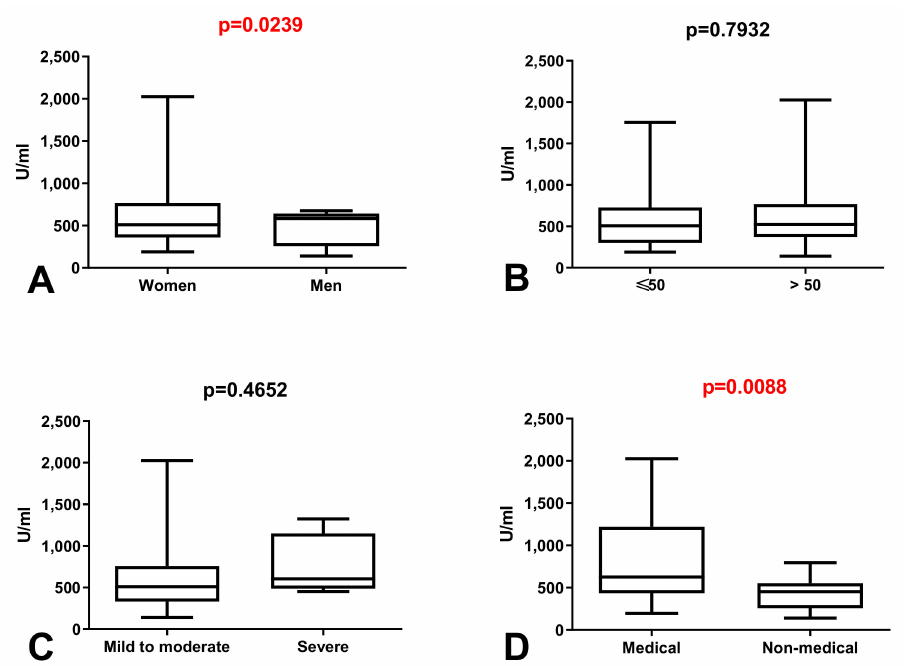
Figure 1. ( A ) Comparison of total anti-SARS-CoV-2 antibodies level between group of women and men without history of COVID-19. The data are presented as median (minimum–maximum). ( B ) Comparison of total anti-SARS-CoV-2 antibodies level between groups of patients before and after the age of 50 without history of COVID-19. The data are presented as median (minimum–maximum). ( C ) Comparison of total anti-SARS-CoV-2 antibodies level between groups of patients with mild to moderate and severe symptoms after vaccination in patients without history of COVID-19. The data are presented as median (minimum–maximum). ( D ) Comparison of total anti-SARS-CoV-2 antibodies level between group of medical and non-medical workers without history of COVID-19. The data are presented as median